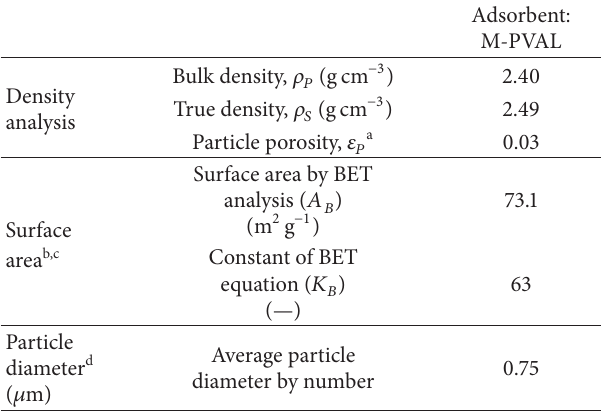
Figure 2: FTIR diagram of M-PVAL. Table 1: Some major physical characteristics of